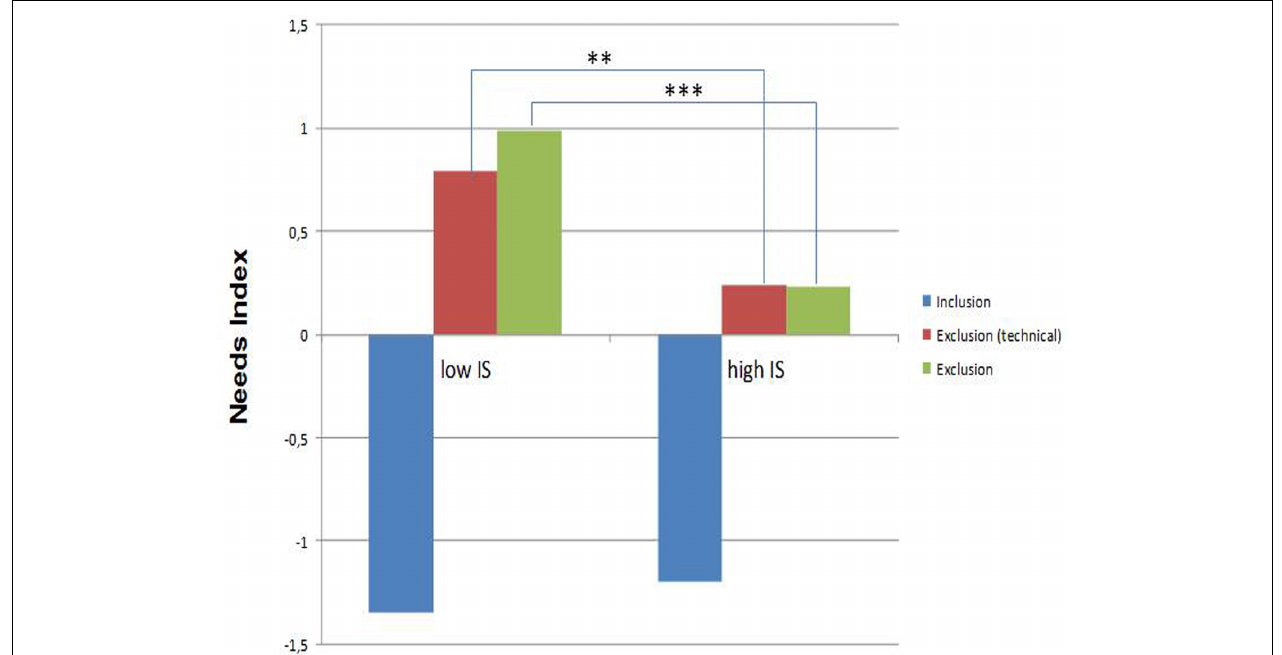
FIGURE 1 | Needs index after cyberball contrasting participants with high and low IS in the three experimental conditions ( N = 69; *** p < 0.001; ** p < 0.01).